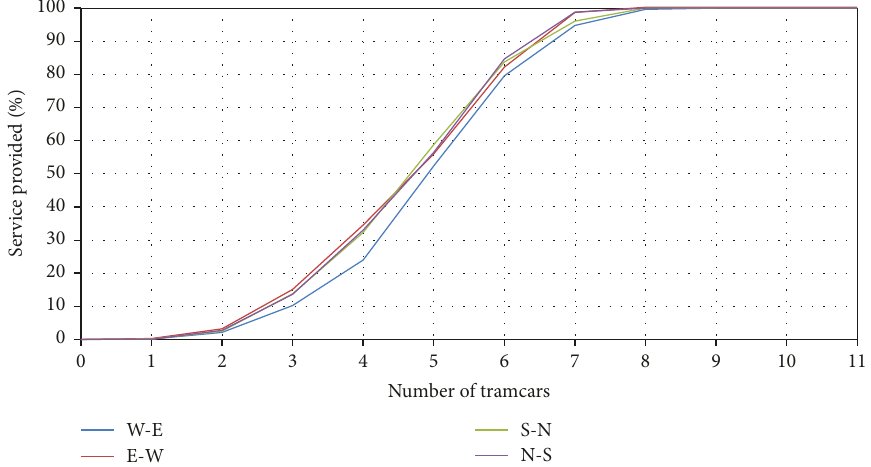
Figure 7: Marginal service provided by adding extra tramcar in both corridors and